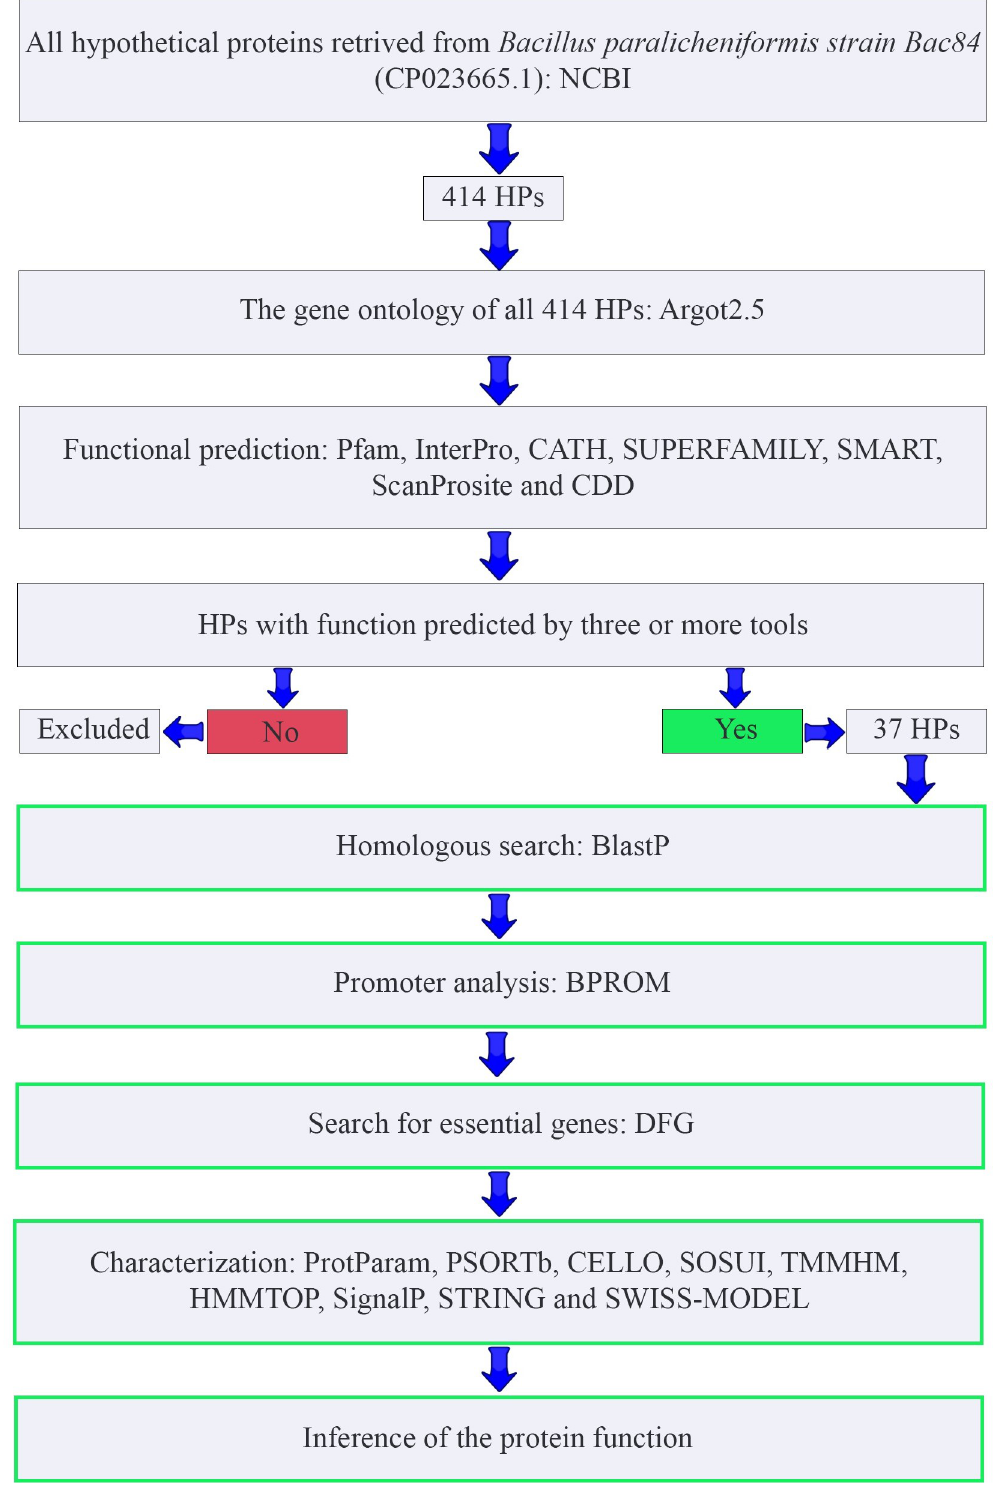
Fig 1. Workflow representing the overall design of the study. The tasks listed in the green outlined boxes were applied only after the analyzed HPs showed the same function in at least three different bioinformatics tools.